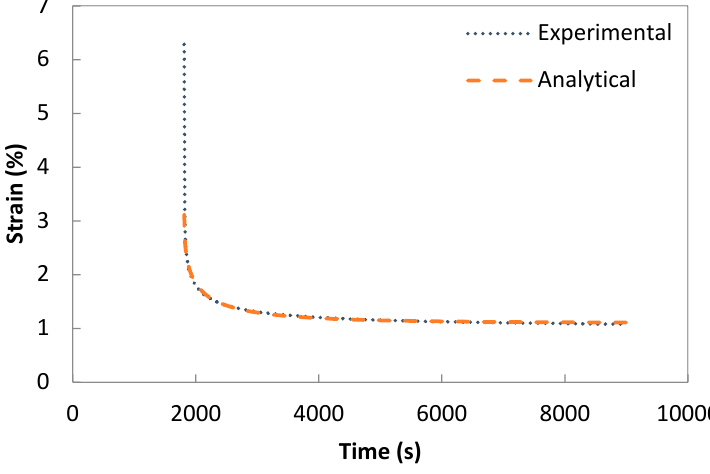
Figure 13. Modelling the recovery component of C-PB5 by a Weibull distribution function.